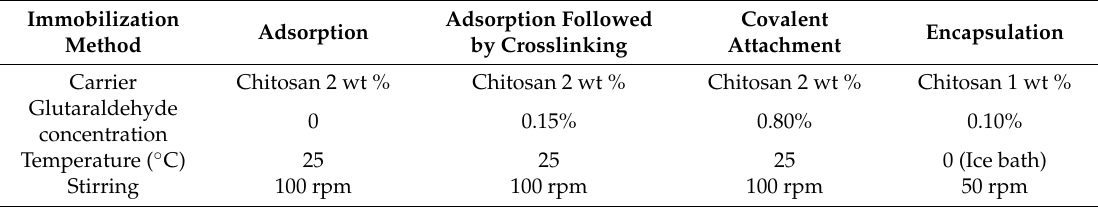
Table 4. Conditions for adsorption, covalent attachment and encapsulation in chitosan using 0.53 mg of protein (crude enzyme) per gram of